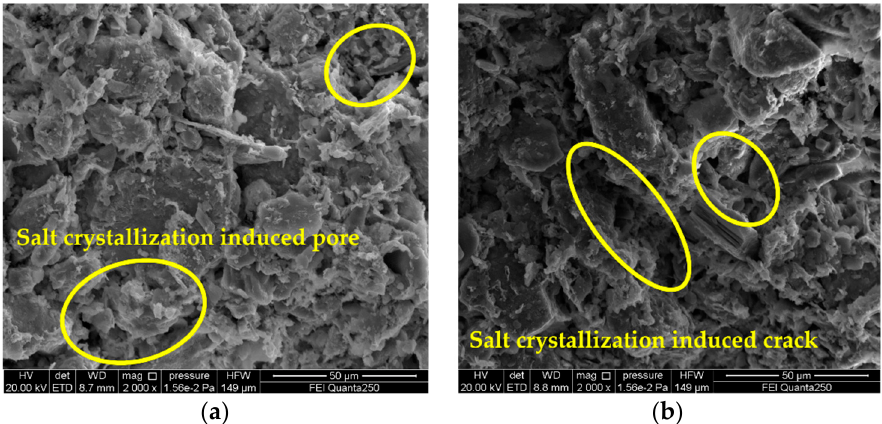
Figure 7. SEM image of gray brick sample of 3% sodium chloride (A 1 B 2 C 2 ) cycled 20 times. Detail of sodium chloride salt crystallization induced micro fissure (yellow circle). ( a ) inside the sample; ( b ) the surface of the sample.